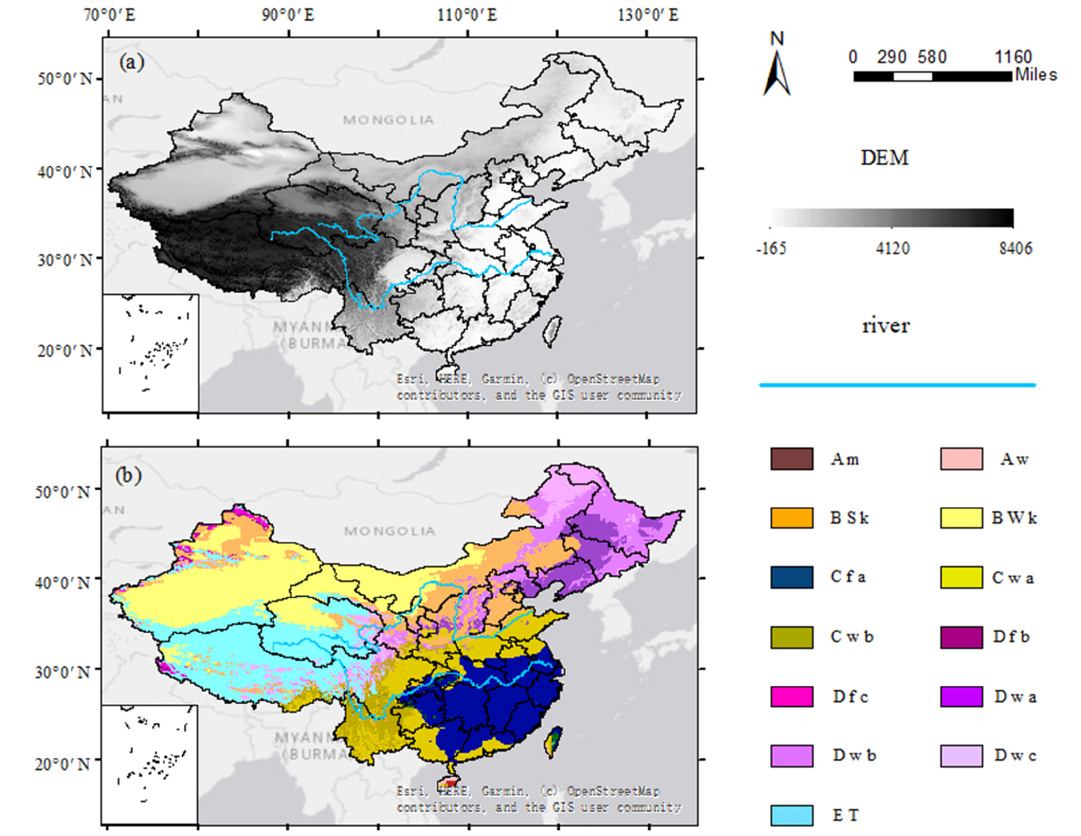
Figure 1. Overview of the study area: ( a ) the digital elevation model (DEM) data, which were acquired from http://www.gscloud.cn/search (accessed on 6 September 2021); ( b ) the climate zone [39], in which the initial character represents the main climates (A: equatorial, B: arid, C: warm temperate, D: snow, E: polar), the second letter means the precipitation (W: desert, S: steppe, f: fully humid,